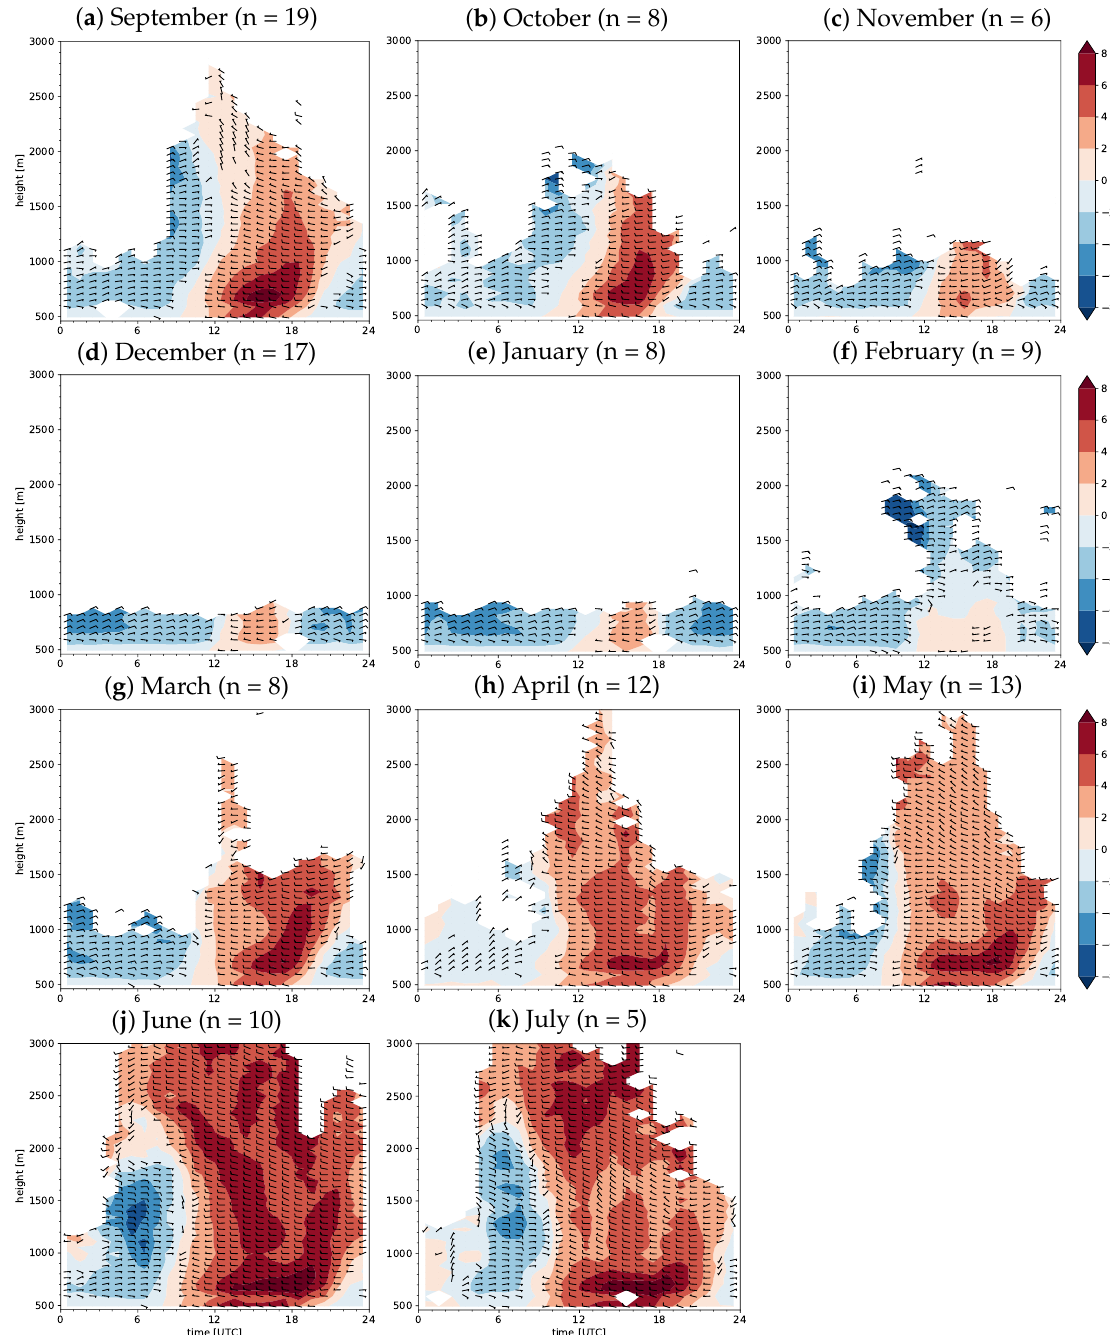
Figure 9. Mean diurnal cycle of the along-valley wind speed (color) and wind direction with respect to the valley’s axis (barbs) for the combined low-mode wind profiler and weather station data, averaged over the valley wind days (n). Note that the mean diurnal cycle is determined by vector-averaging, thus a wind with random variations of the direction would average to zero. The wind speed is masked if more than 50% of the values are missing, and wind barbs are plotted if the wind speed is greater than 2.5